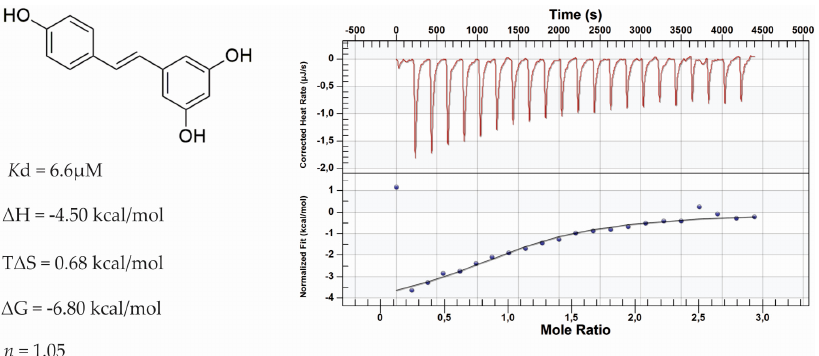
Figure 1. Isothermal Titatrion Calorimetry (ITC) data for RSV. Reverse titration of BRD4(1) into RSV buffered, BRD4(1): 400 µM, RSV: 17 µM.